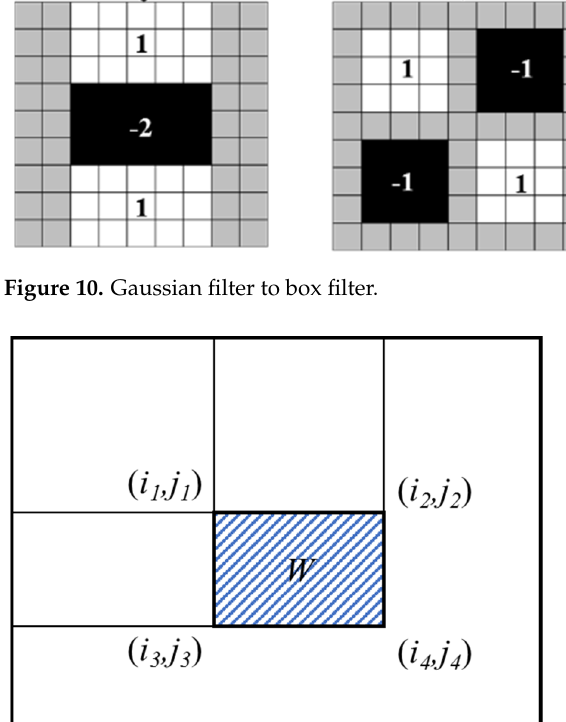
Figure 10. Gaussian filter to box filter.